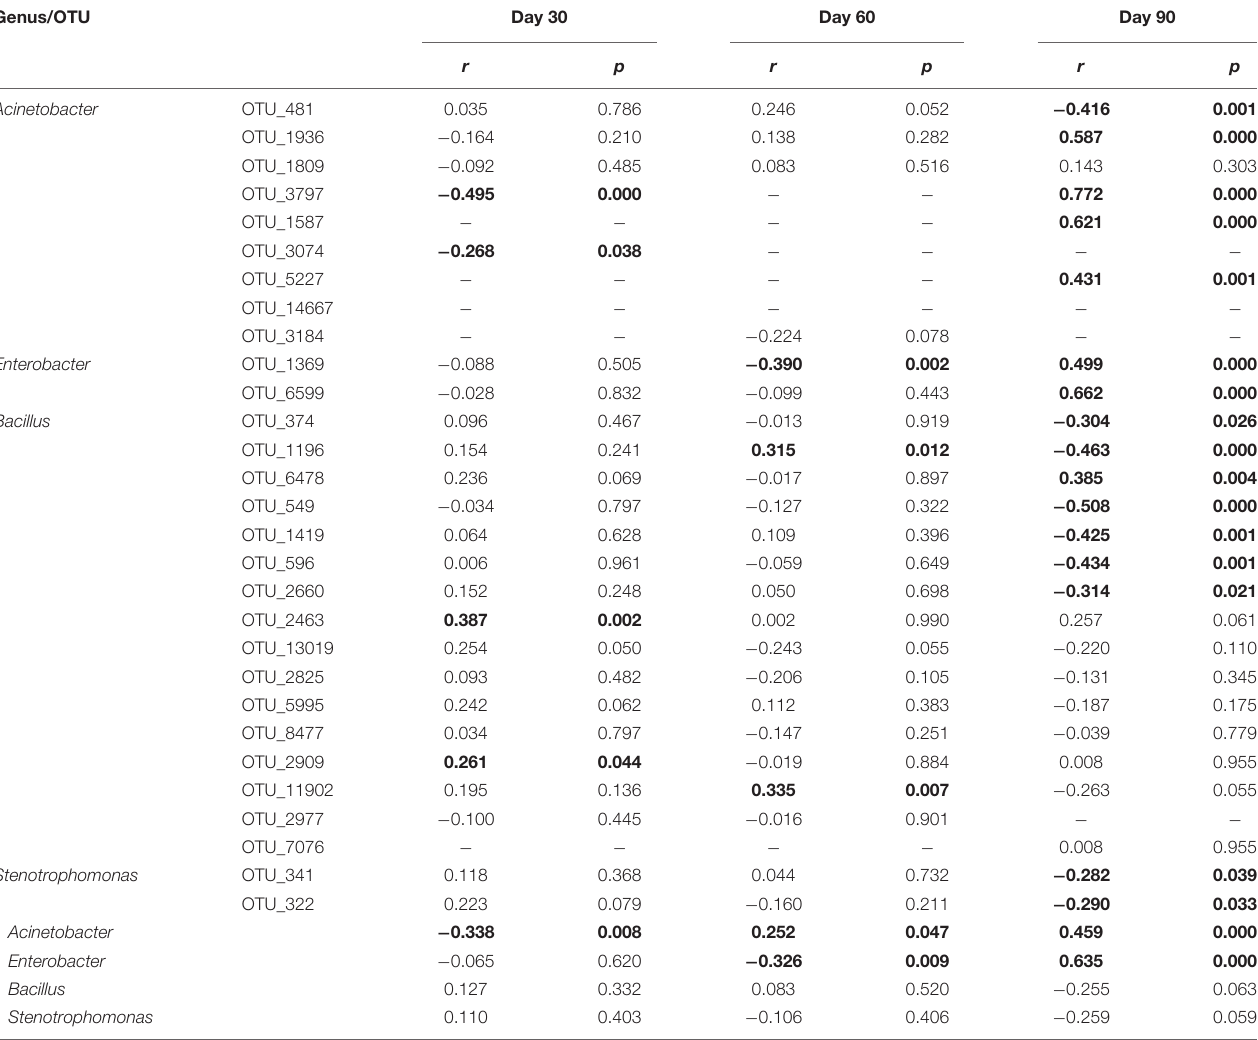
TABLE 2 | Correlated the control effects on black shank and functional OTUs/genera in soil bacterial communities during tobacco planting using Spearman’s ranked correlation tests.